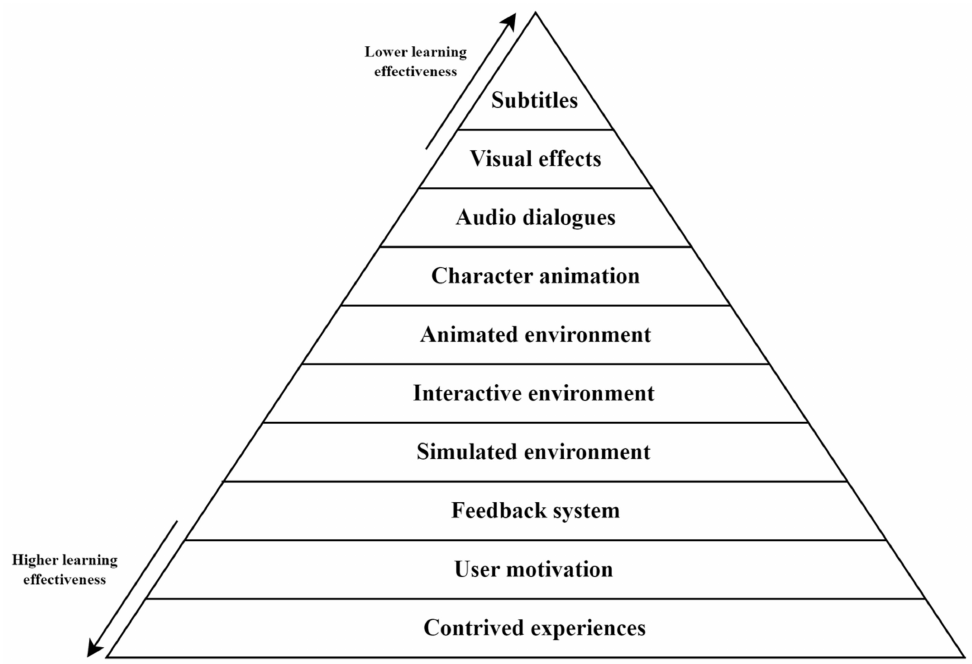
Figure 8. Learning effectiveness pyramid in a virtual reality training. Modified from